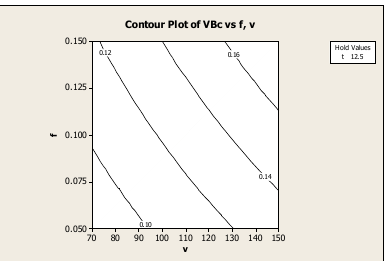
Fig.8. Contour plot of flank wear (VBc) in v-t